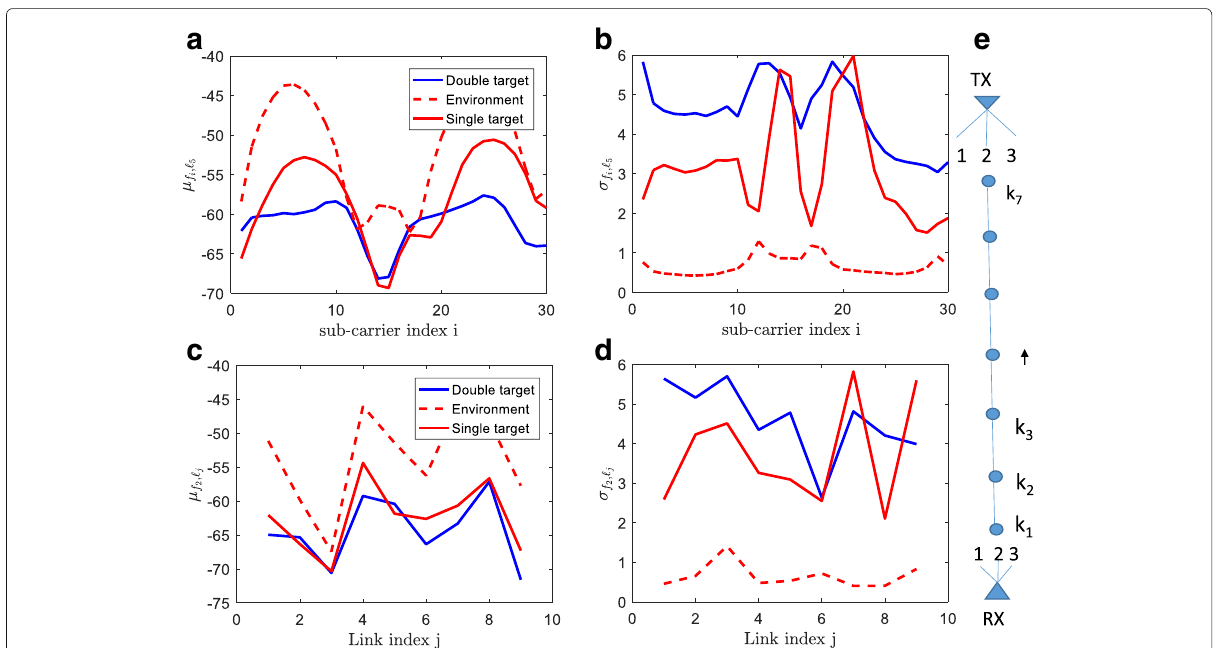
Fig. 2 a Mean and b standard deviation of the power measurements of empty and occupied environment acquired by the MIMO receiver RX for the given link (cid:2) 5 in the frequency domain. c Mean and d standard deviation of the power measurements in space domain for the given sub-channel f 2 . In e , the layout adopted for both single and double target experimental measurements is